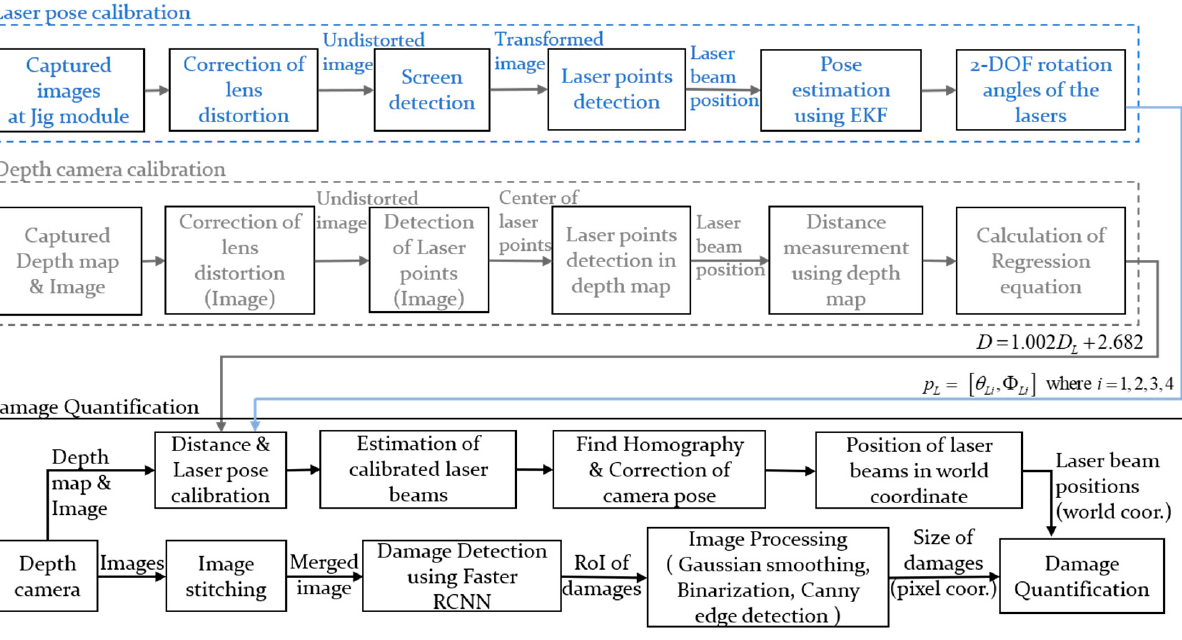
Figure 2. Schematic diagram of structural damage quantification.